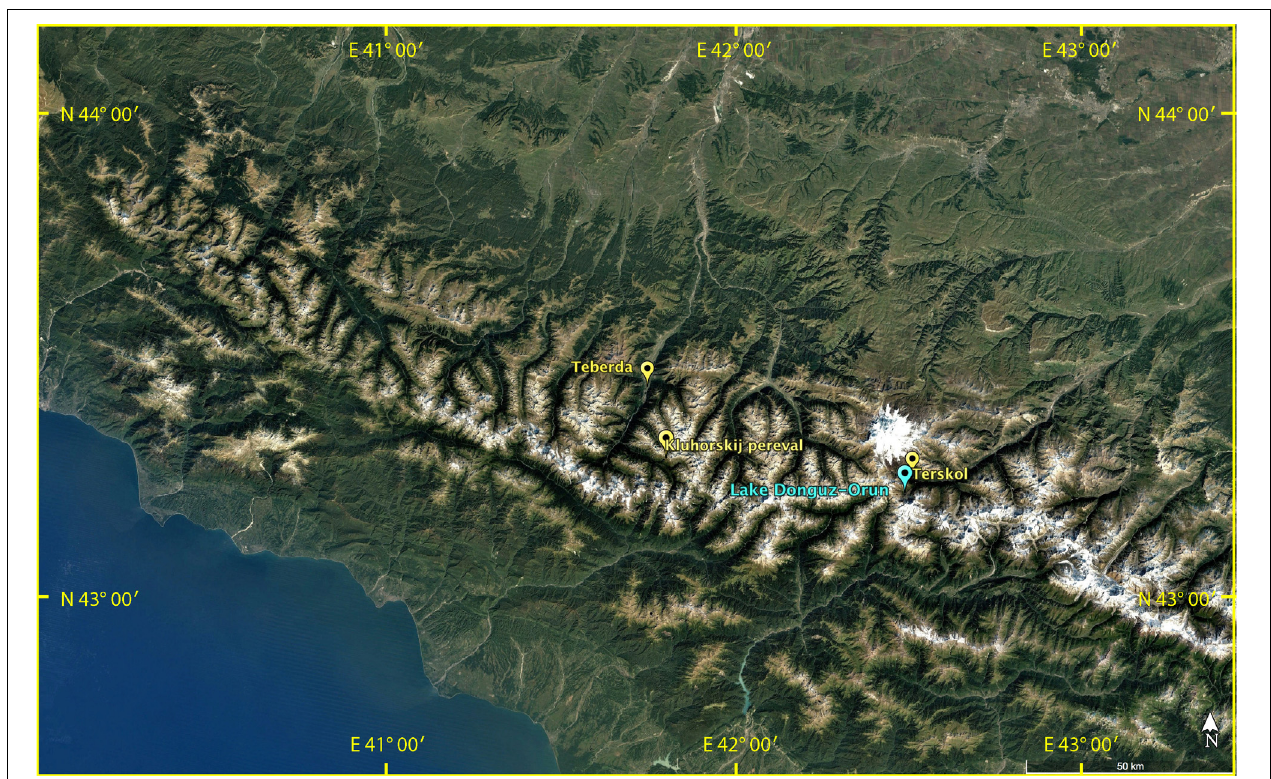
FIGURE 1 | The Caucasus, location of the Lake Donguz-Orun. Blue mark shows the lake, yellow marks show the featured meteorological stations.